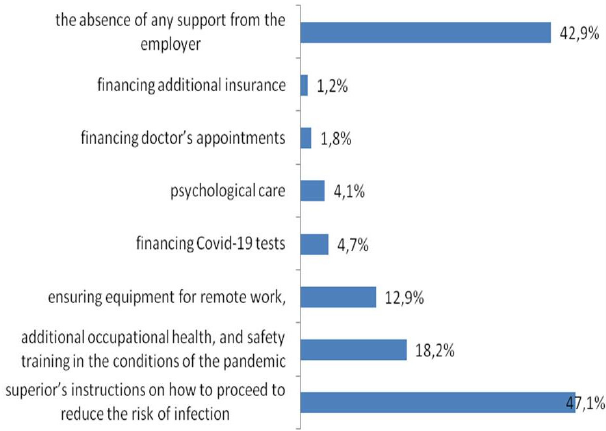
Figure 6. Support granted by employers to employees amidst the Covid-19 pandemic*. * Respondents could se- lect more than one